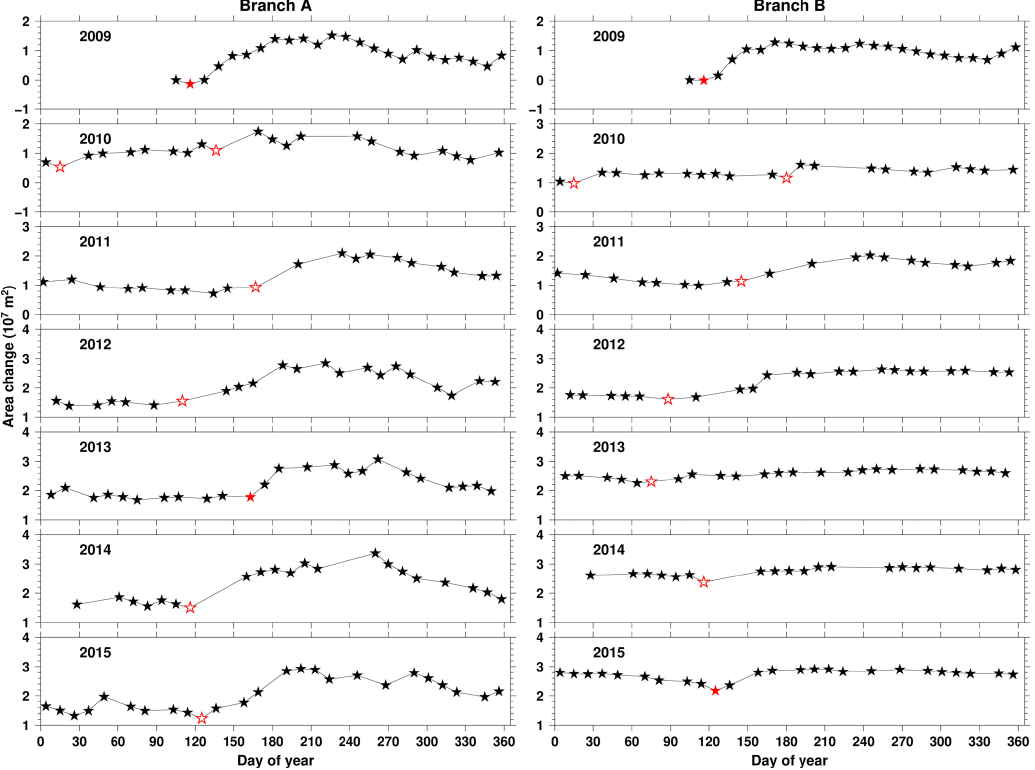
Figure 7. Similar to Fig. 5 but showing the time series of calving front changes (in area changes) of our deep-learning-based results in different years. The red filled stars mark the dates when the glacier started to retreat. Red open stars mark starting dates that cannot be reliably determined due to data gaps (e.g., Branch A in 2011) and small variations (e.g., Branch B in